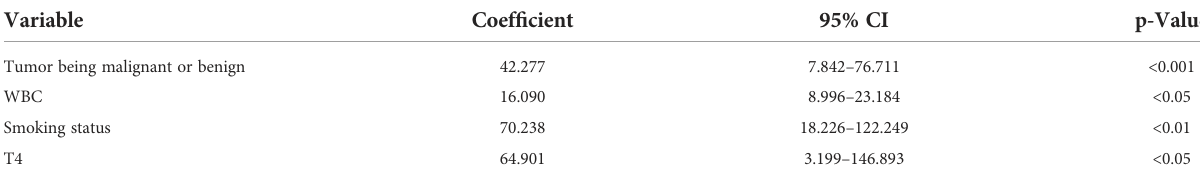
TABLE 5 Multivariate analysis of correlation between tumor being malignant or benign, white blood cell count, smoking status, tumor stage, and LIT score.